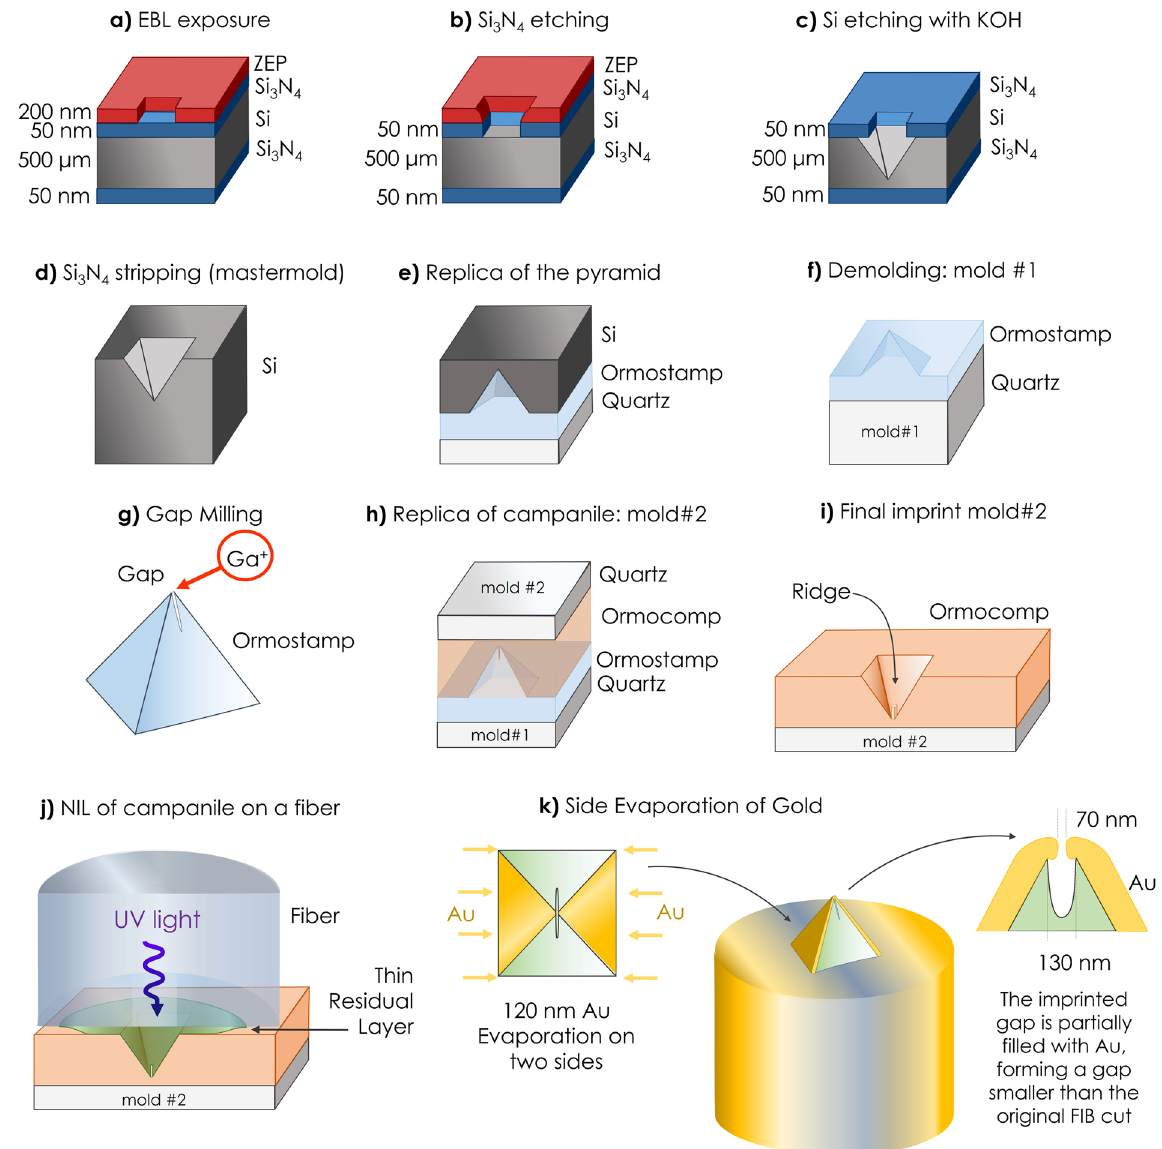
Figure 2. Fabrication process. (a) EBL exposure and development of ZEP. ( b) Pattern transfer into Si 3 N 4 by RIE. ( c) The undercut of silicon in KOH to form inverted pyramids. ( d) Si 3 N 4 stripping and completion of the mastermold. ( e ) Replication of the mastermold into Ormostamp to form pyramids. ( f ) Demolding and completion of mold #1. ( g ) Ga + FIB milling of the gap at the apex of the pyramid. ( h ) Replication of milled pyramids into Ormocomp. ( i ) Demolding and completion of mold #2 on a quartz substrate. ( j ) Imprint on a fiber using the process described in 28 . ( k ) Evaporation of 120 nm Au on two of the four sides of the pyramid. The imprinted slit at the apex prevents gold from shortcutting the two sides and creates a plasmonic gap at the tip of the